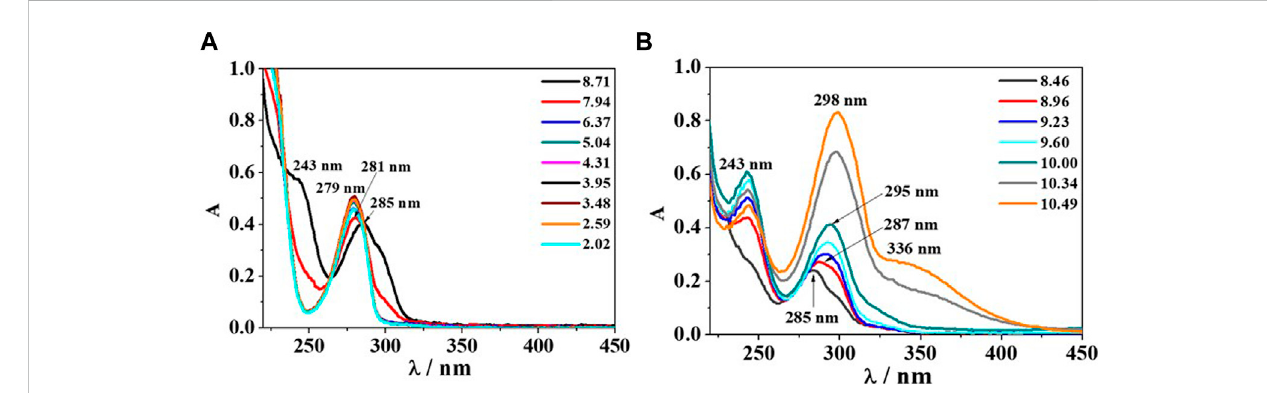
FIGURE 7 UV-Vis spectra of Eph − / Alg 2- system at c Eph- = c Alg 2- = 0.12 mmol dm − 3 , T = 298.15K and different pH values; (A) UV-Vis scans recorded in the pH range 8.71 – 2.02; (B) UV-Vis scans recorded in the pH range 8.46 –